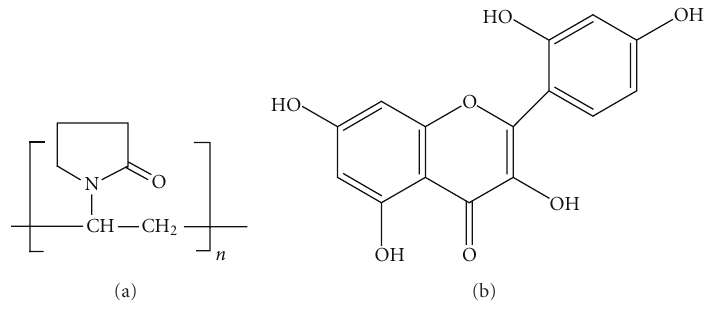
Figure 1: The structures of PVP (a) and morin